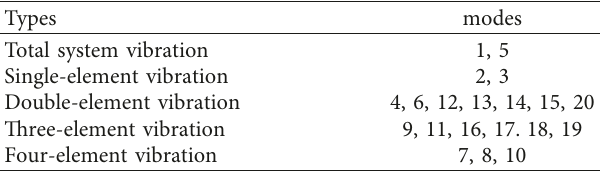
Table 3: Types of the vibration modes of the drive system.